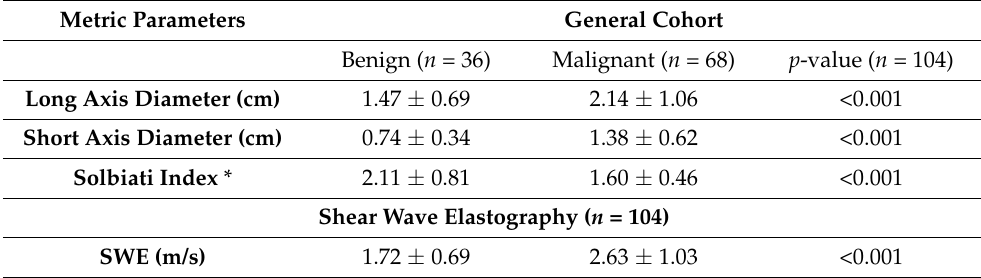
Table 2. Analysis of general cohort. All metric variables are given as mean with corresponding standard deviation. Abbreviations: SWE, shear wave